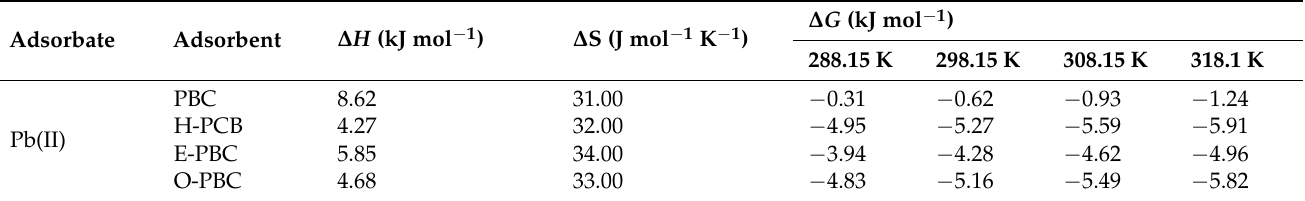
Table 3. Thermodynamic parameters for the adsorption of Pb(II) by PBC, H-PCB, E-PBC, and O-PBC at different